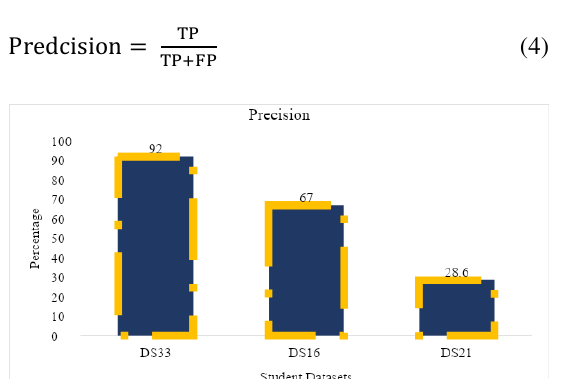
Fig. 4: Comparison of Prediction of FCBF on three datasets